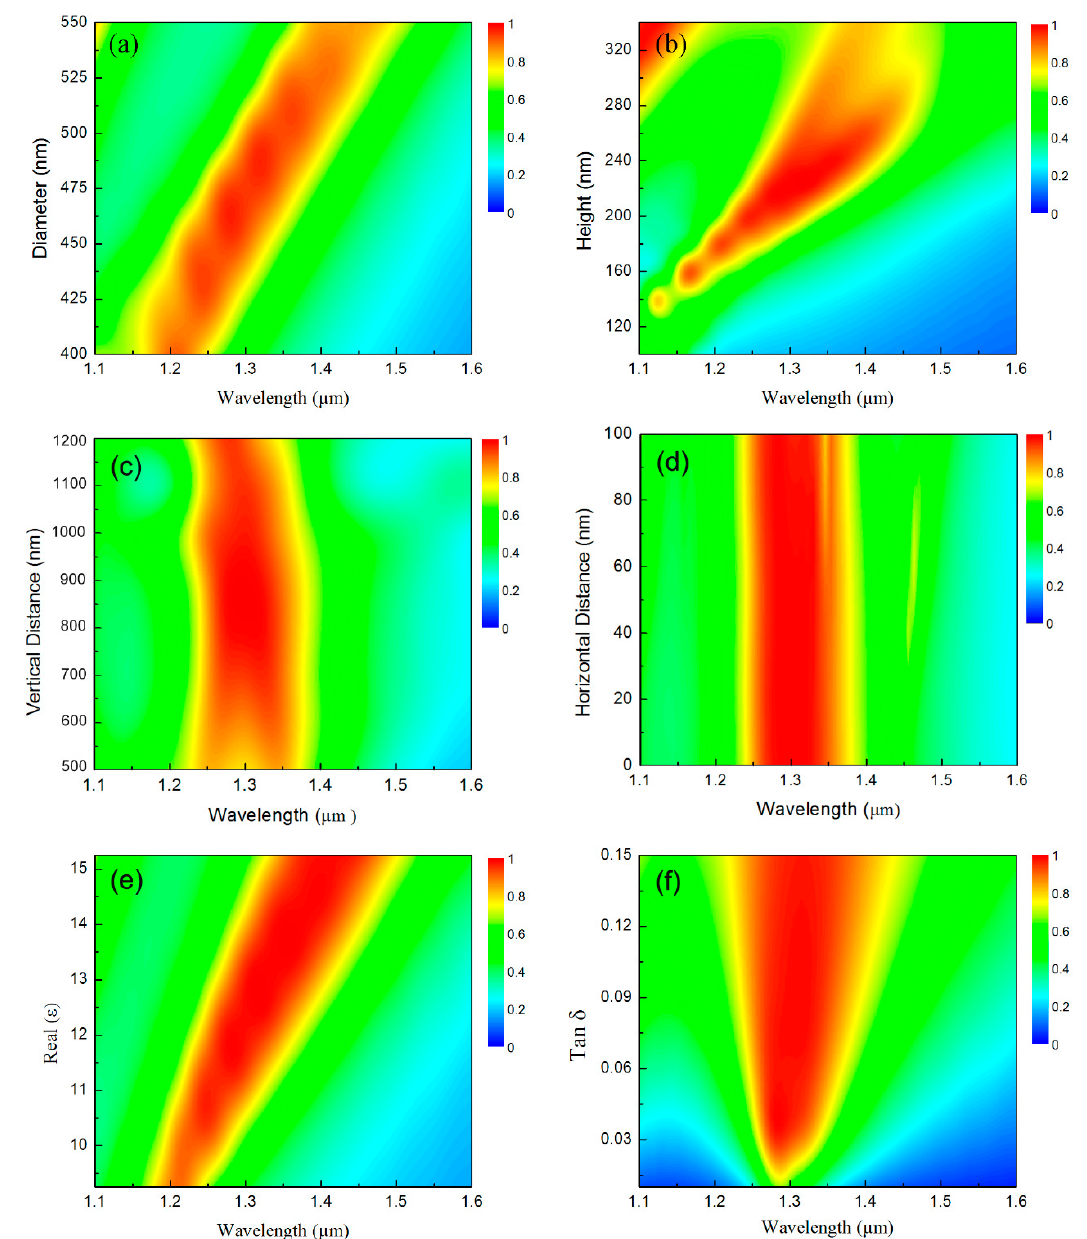
Figure 4. Robust perfect absorption properties of the proposed broadband all-dielectric metasurface. The dependence of the absorbance on the operating wavelength are on: ( a ) the diameter; ( b ) the height of the silicon disks; ( c ) the vertical and ( d ) the horizontal distances between the centers of the two silicon disks; ( e ) the real part of the permittivity; and ( f ) the loss tangent of the silicon